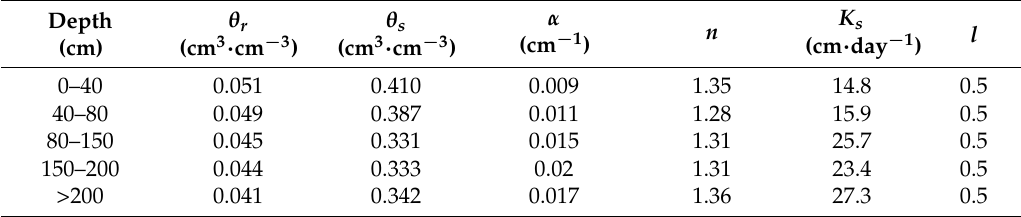
Table 3. The optimized soil hydraulic parameters used for the Hydrus -2D